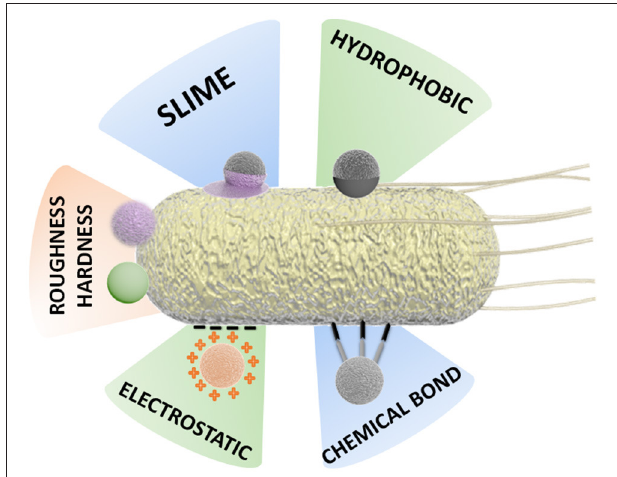
FIGURE 3 | Schematic representation of different attachment strategies for the preparation of